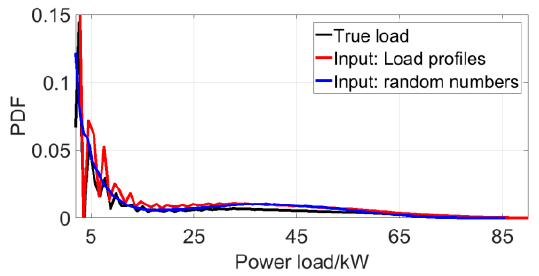
Figure 13. Probability density function of PHEV_NODR.